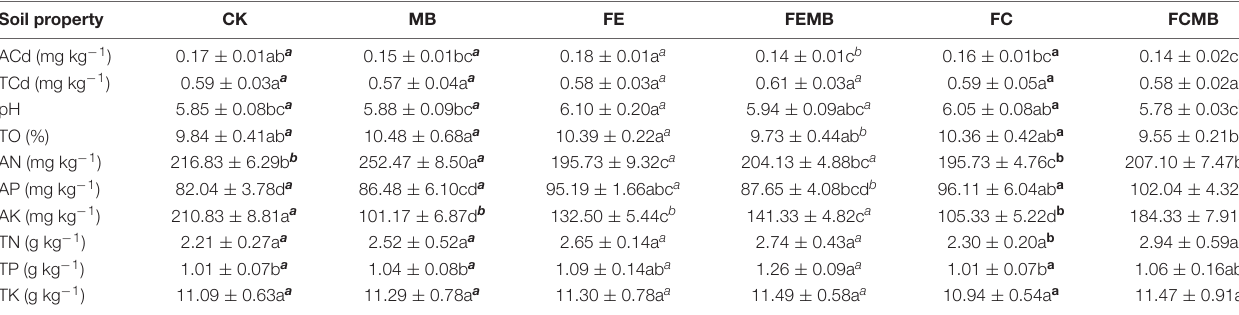
Different lowercase letters indicate significant differences (p < 0.05). Italic bold superscript letters indicate differences between CK and MB; italic superscript letters indicate differences between FE and FEMB; bold superscript letters indicate differences between FC and FCMB. Conventional letters indicate differences of the same